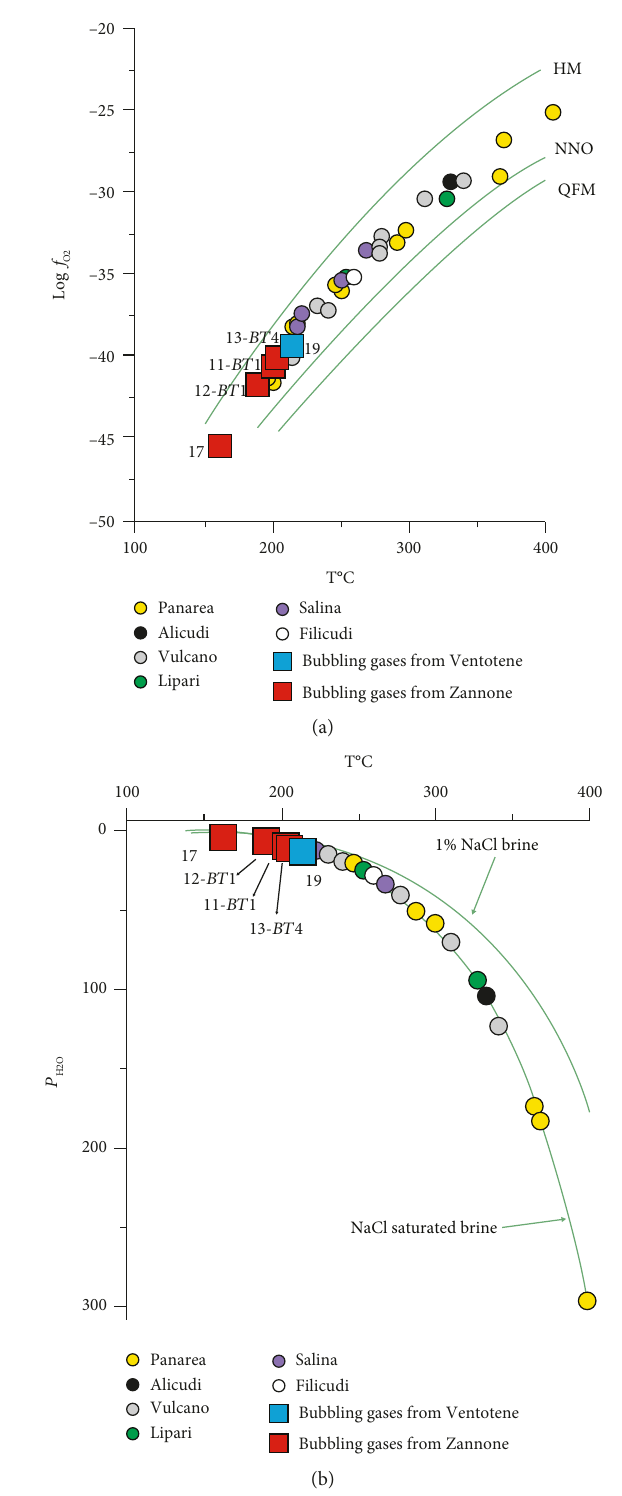
Figure 8: Geothermometric and geobarometric estimations for the bubbling gases from Zannone and Ventotene (see text and Section 1 of Supplementary Materials for details). B-Z2 and B-VEN were analyzed in this paper; B1, B2, and B3 after Martorelli et al. [27]: (a) temperature vs. oxygen fugacity (expressed as log f ) diagram; geothermometric estimations for the submarine hydrothermal systems O2 of the Aeolian Islands are reported for comparison. The solid bu ff ers quartz – fayalite – magnetite (QFM), nickel – nickel oxide (N – NO), and hematite – magnetite (HM) are plotted as reference (after Eugster and Wones [84]). (b) Estimated equilibrium pressure of the hydrothermal reservoirs. The pressure is shown on the vertical axis as P (bars). The boiling curves for saturated NaCl and 1%NaCl H2O by using the estimated equilibrium waters (brines) are shown. P H2O